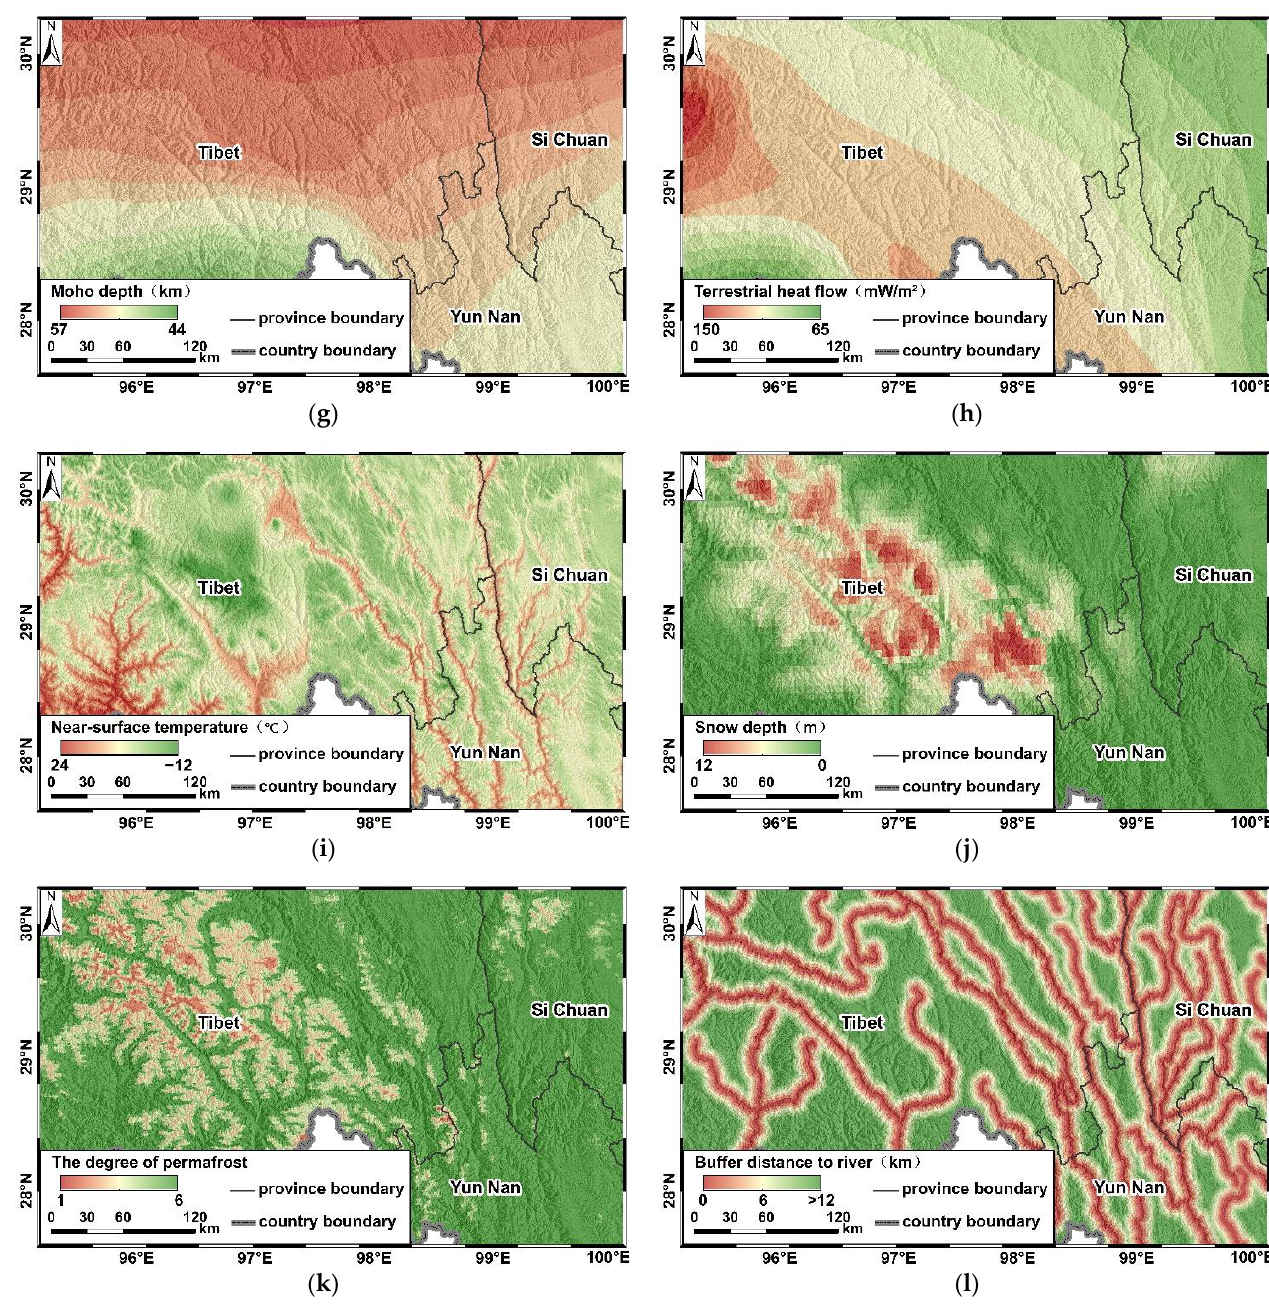
Figure 4. Environmental variables: ( a ) Land surface temperature, ( b ) Buffer distance to fault, ( c ) Combined entropy of geological formation, ( d ) Earthquake peak acceleration, ( e ) Epicentral nucleus density, ( f ) Aeromagnetic anomaly, ( g ) Moho depth, ( h ) Terrestrial heat flow, ( i ) Near-surface temperature, ( j ) Snow depth, ( k ) The degree of permafrost, ( l ) Buffer distance to river.